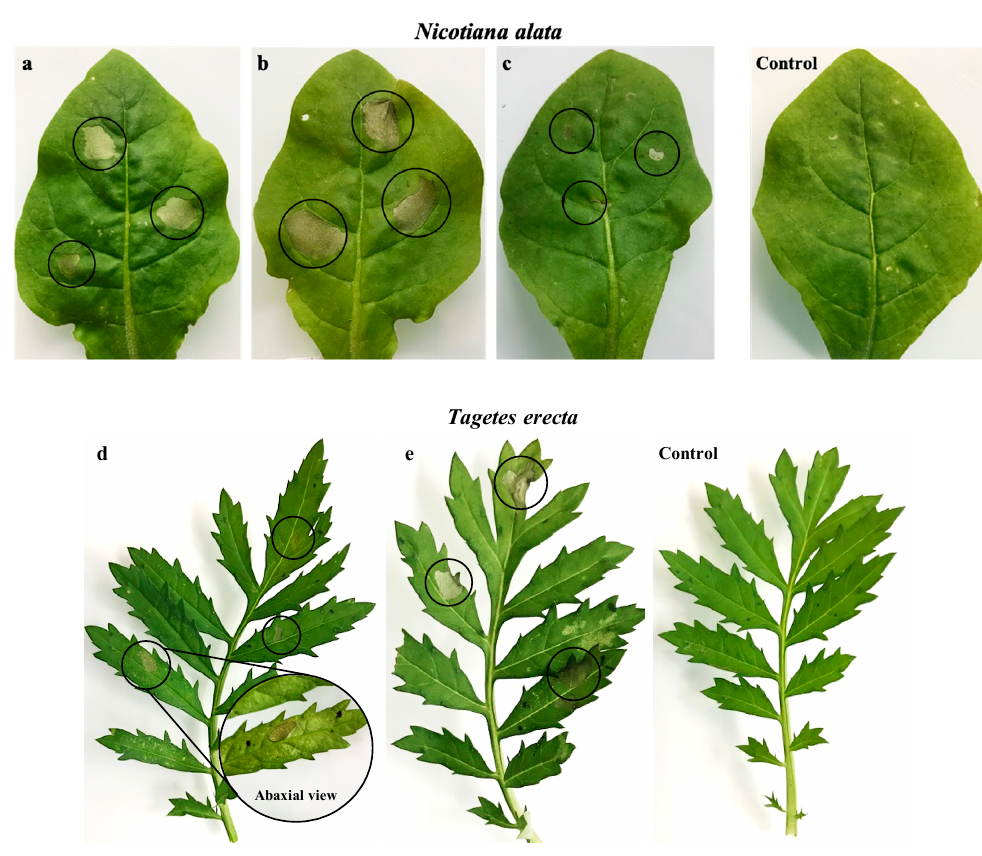
Figure 2. Leaf infiltration assay. Phytotoxic damage of α -acetylorcinol ( 1 ) and p -hydroxybenzoic acid ( 2 ) on tobacco ( N. alata ) and marigold ( T. erecta ) leaves: ( a ) p -hydroxybenzoic acid (14.5 mM), ( b ) p -hydroxybenzoic acid (22.0 mM), ( c ) α -acetylorcinol (22.0 mM), ( d ) p -hydroxybenzoic acid (14.5 mM), and ( e ) p -hydroxybenzoic acid (22.0 mM). The sterile uninoculated medium was used as a control. The circle indicates the phytotoxic effect.